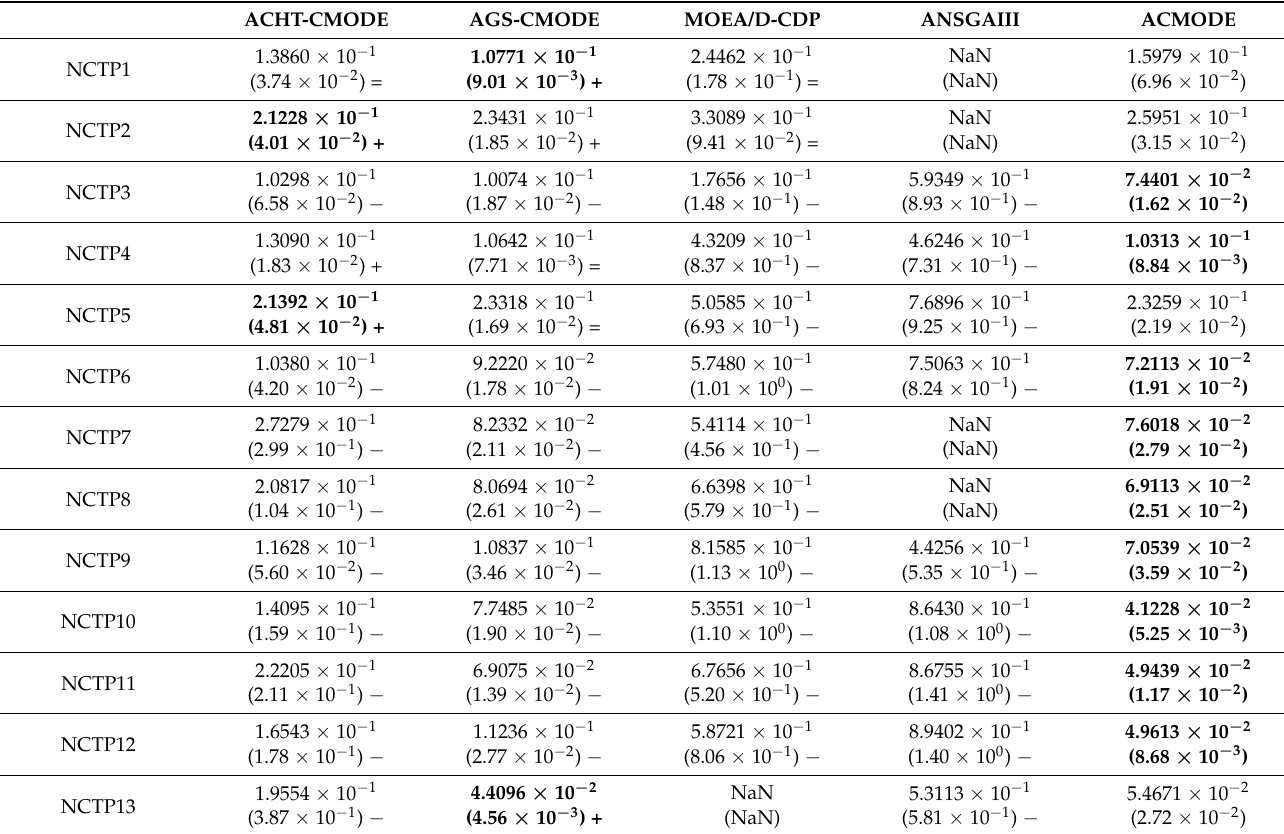
Table 6. IGD results of all comparison algorithms on NCTP test